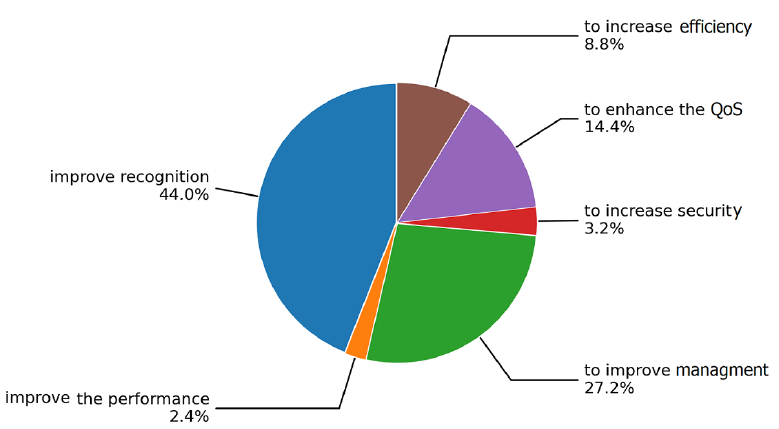
Figure 25. Motivations of adopting AI solutions to context